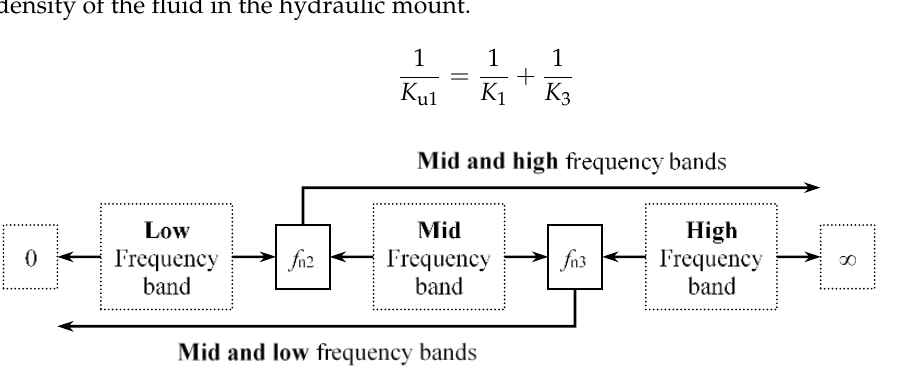
Figure 3. Low-, mid-, and high-frequency bands for the dynamic analysis of AHM-IT-DM-OCA [22]. Mathematical models were established and simplified for different frequency